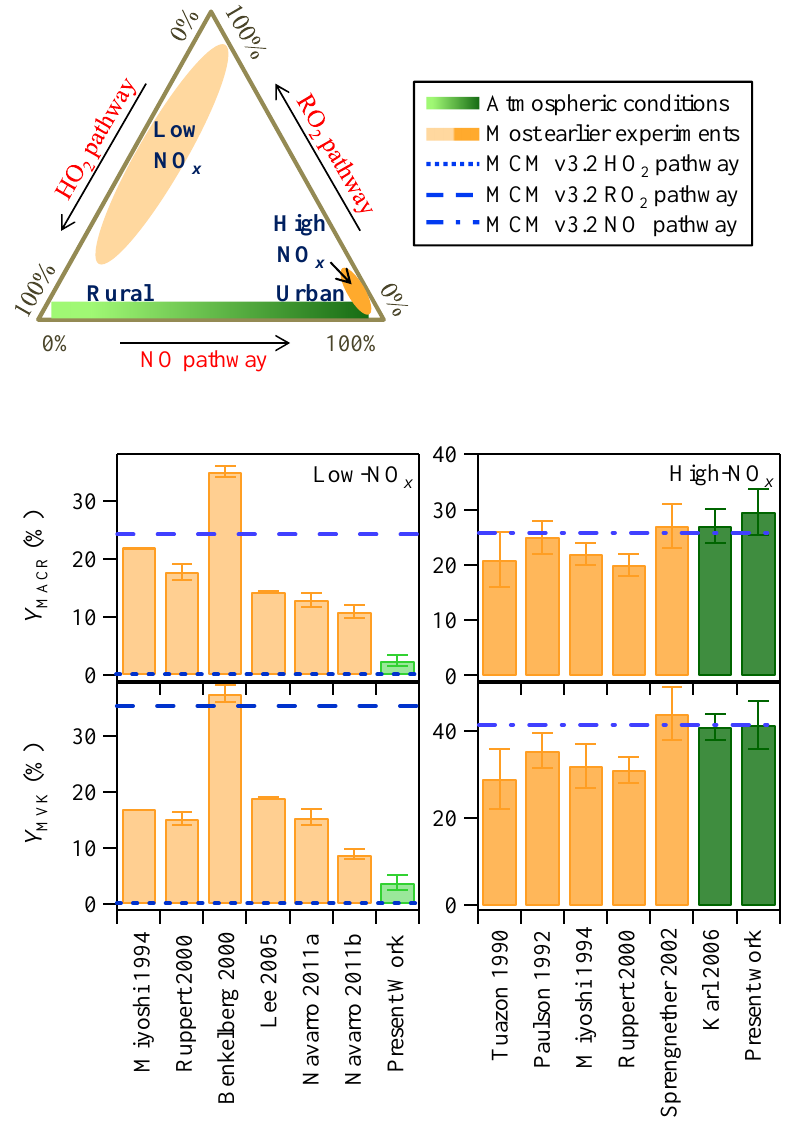
Fig. 5. Comparison of the MVK and MACR yields from ISOP photo-oxidation in this study with those in earlier studies for conditions described in those studies as “low NO x ” and “high NO x ” (bar) and with those of RO 2 , HO 2 , or NO pathways represented in MCM (line). The inset triangle diagram represents environmental factors that can affect the dominant reaction pathways of isoprene-derived ISOPOO radicals in the atmosphere and in the laboratory studies. The isomerization pathway is not included due to its small contribution in most laboratory studies, although it could be important in remote atmospheric conditions. Cited studies: Tuazon and Atkinson (1990), Miyoshi et al. (1994), Paulson et al. (1992), Benkelberg et al. (2000), Ruppert and Becker (2000), Sprengnether et al. (2002), Lee et al. (2005), Karl et al. (2006), and Navarro et al. (2011). The modeled ratio of HO 2 to RO 2 is 0.1 and 1 in Navarro (2011) Exp a and Exp b,